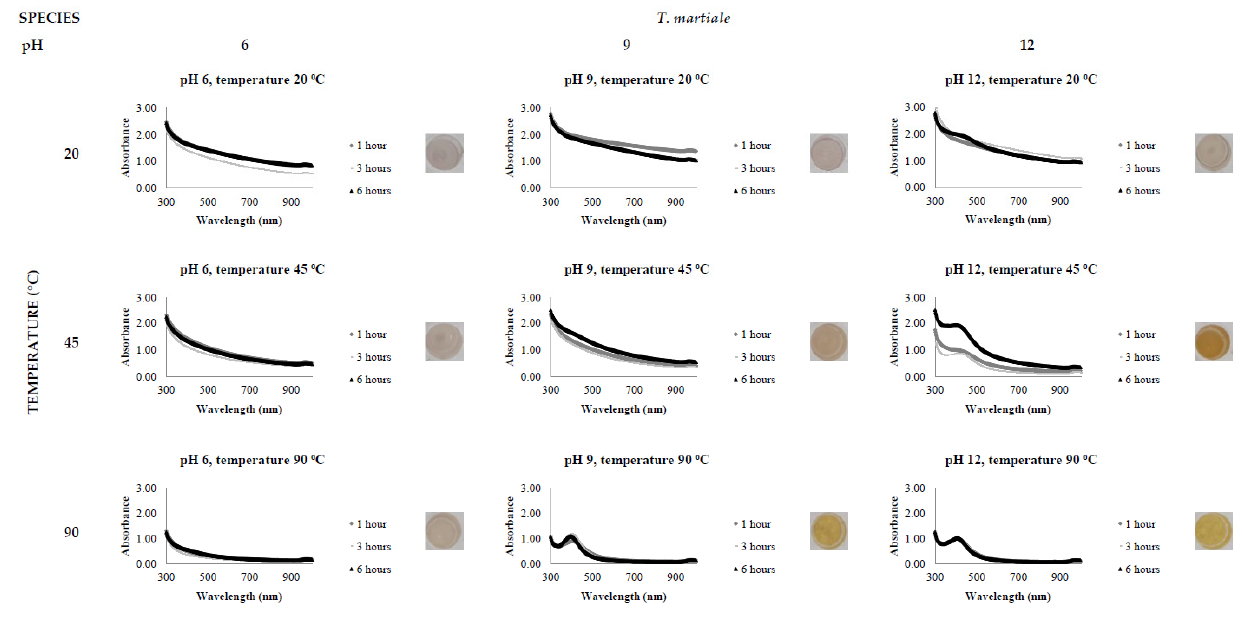
Figure 5. LSPR spectra of T. martiale cell-free extract in the synthesis of AgNPs, by the addition of 0.5 mM AgNO 3 , varying the reaction time (1, 3 and 6 h), temperature (20, 45 and 90 °C) and pH (6, 9 and 12), through UV-Vis spectrophotometry analysis.